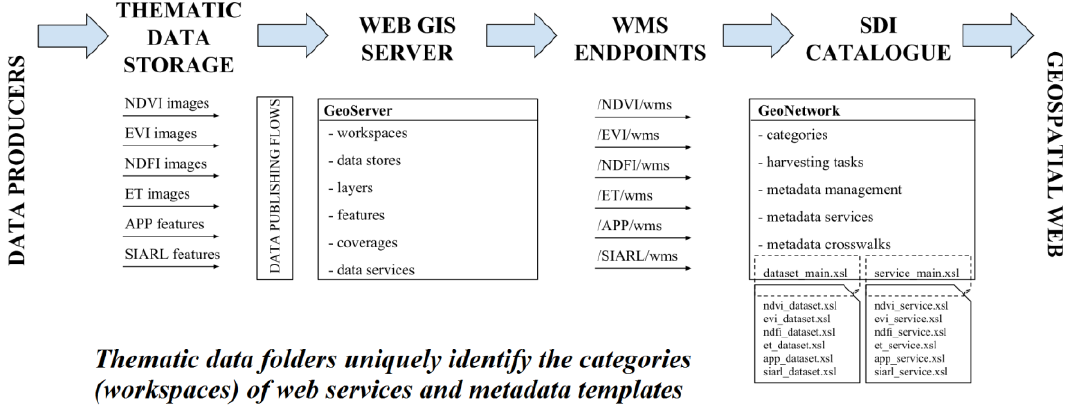
Figure 4. Schematic representation of the workflow designed to automate the process of GD and